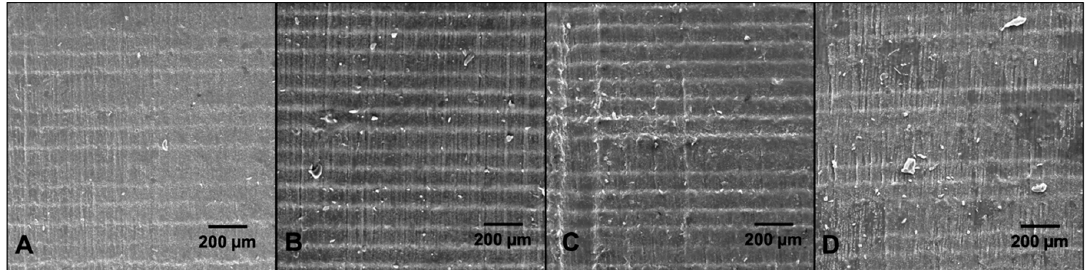
Figure 5. Surface characterization of Formlabs Elastic polymer after 7 day liquid exposure at 37 °C. Representative SEM images from ( A ) control, ( B ) water-exposed, ( C ) PBS-exposed, ( D ) BAS-exposed (N = 3 per condition).